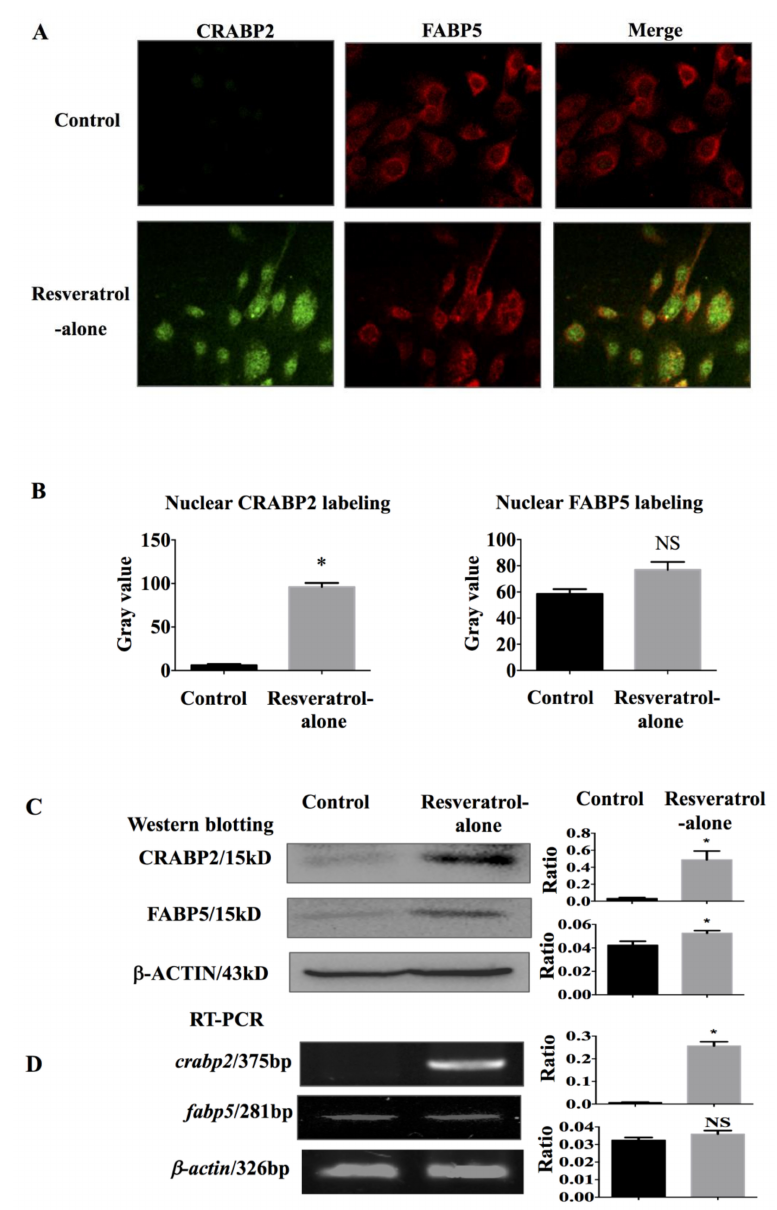
Figure 4. Differential expression of CRABP2 and FARP5 in THJ-11T cells in the absence or presence of 100 µ M resveratrol. ( A ) Double immunofluorescent labeling ( × 40); ( B ) ImageJ (Version 1.0, National Institutes of Health, Bethesda, MD, USA)-based quantification of nuclear labeling of CRABP2 and FABP5; ( C ) Western blotting; ( D ) RT-PCR. Control, 0.2% DMSO-treated cells; Resveratrol-alone, 100 µ M resveratrol treatment; Ratio, ratio between the levels of the target molecules and that of β -ACTIN/ β -actin ; *, with statistical significance ( p < 0.05); NS, no statistical significance ( p > 0.05); the error bars, the mean ± standard